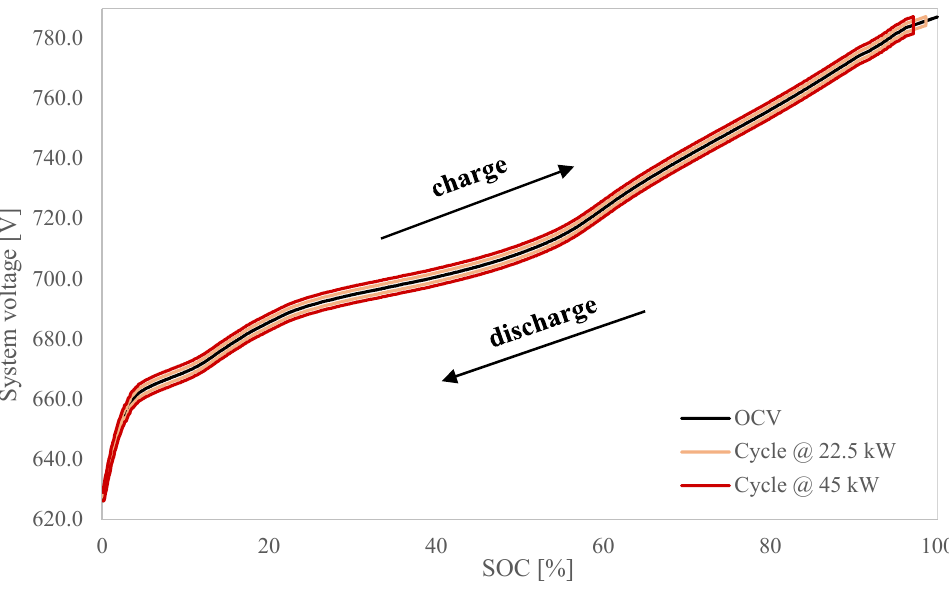
Figure 3. Voltage diagram for test Set 1.